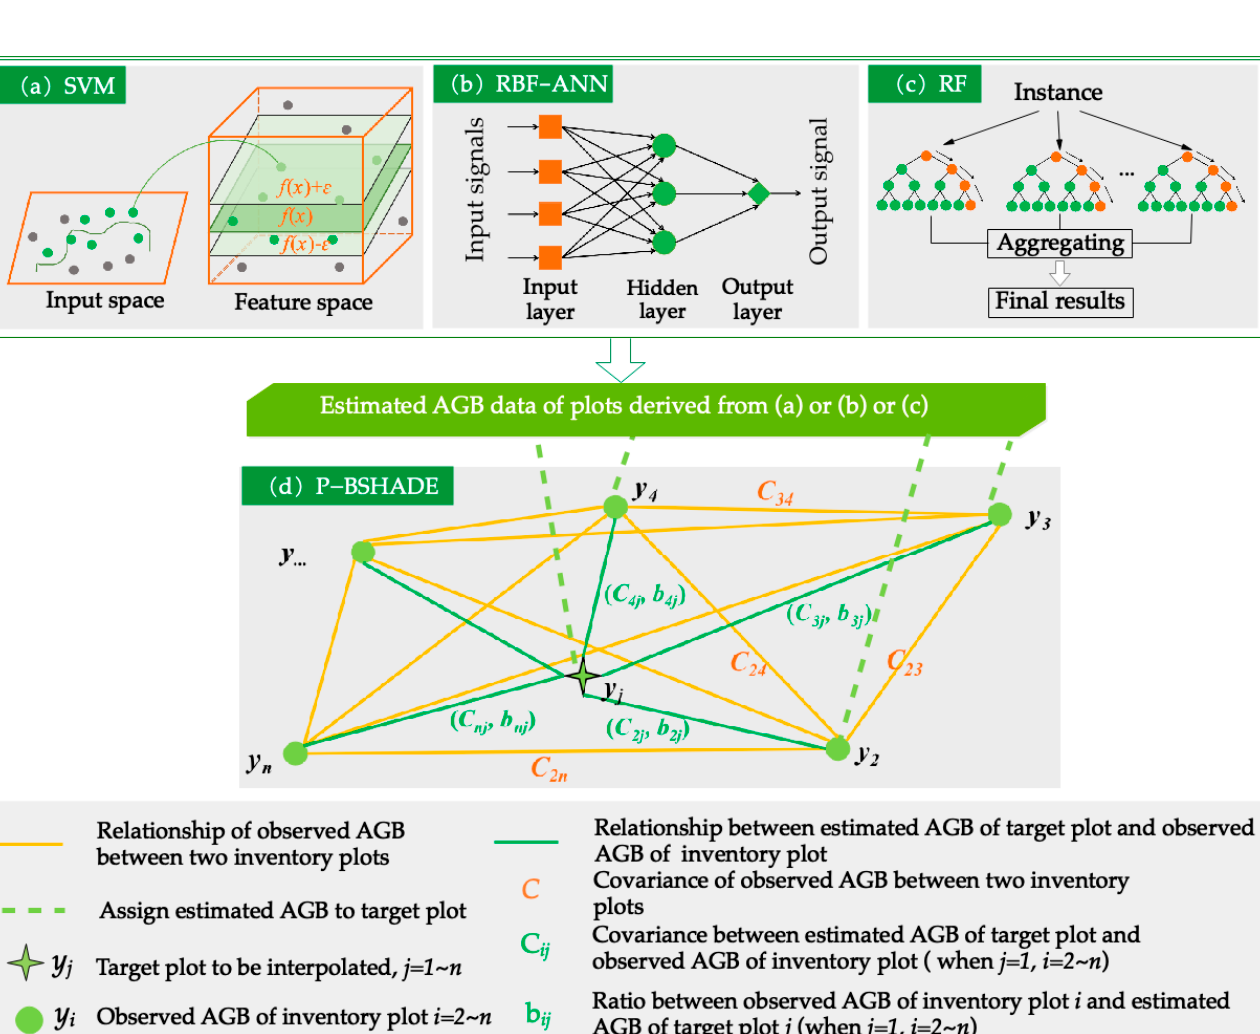
Figure 2. Framework for estimating ( a – c ) the machine learning models, ( d ) the P-BSHADE model, and the three models that combine machine learning with the P-BSHADE model [( a , d ), ( b , d ) and ( c , d )].